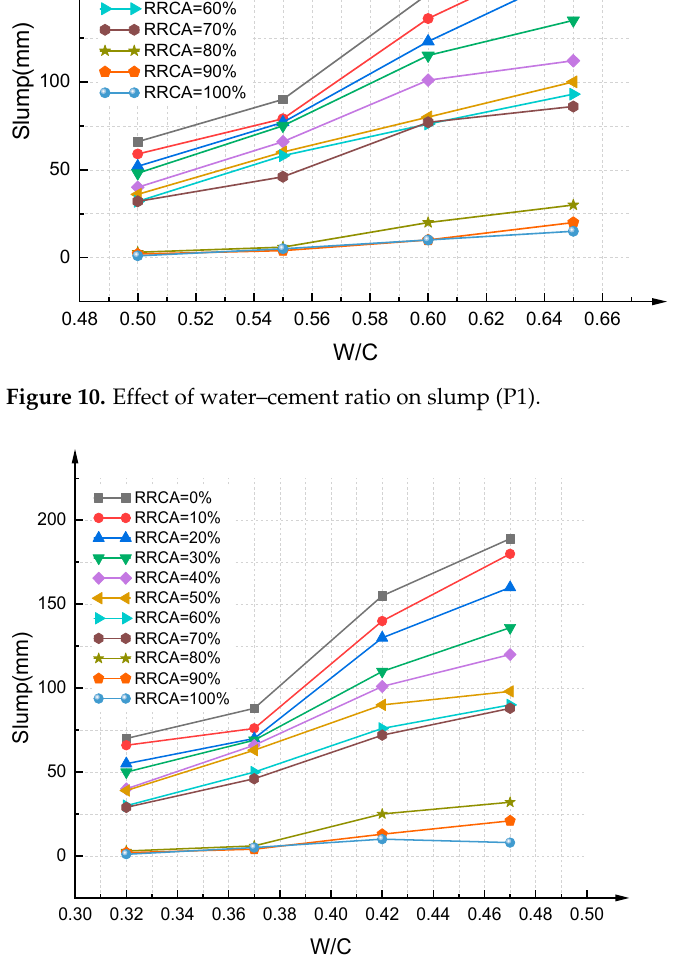
Figure 11. Effect of water–cement ratio on slump (P2).